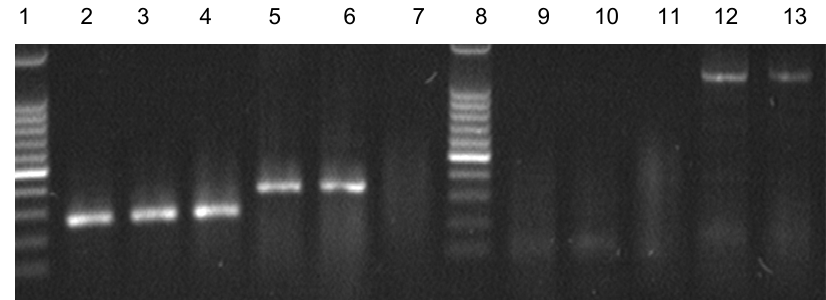
Figure 1. Lanes 1 and 8: 100bp molecular-weight marker; Lanes 2 to 7: amplifications of the β -actin gene using the β 1/ β 2 set of primers; Lanes 9 to 13: amplifications of the G gene using the G1/G2 set of primers; Lanes 7 and 9: negative control (distilled